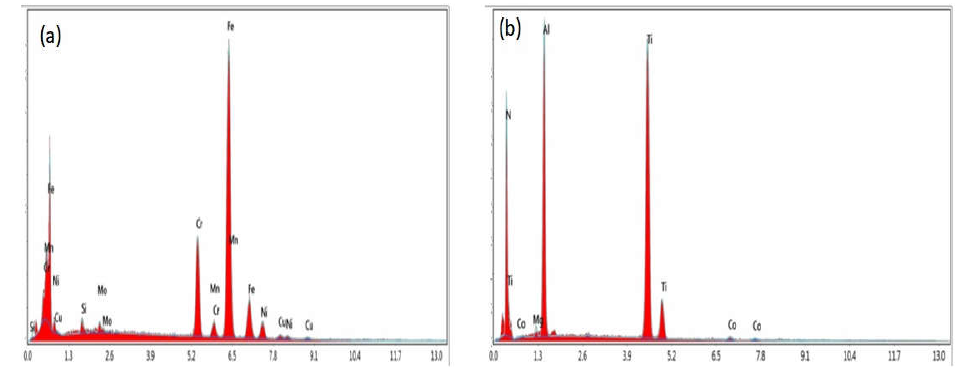
Figure 1. EDS analysis of ( a ) base materials (Custom-450 grade stainless steel) and ( b ) tungsten carbide tool with TiAlSiN coating.